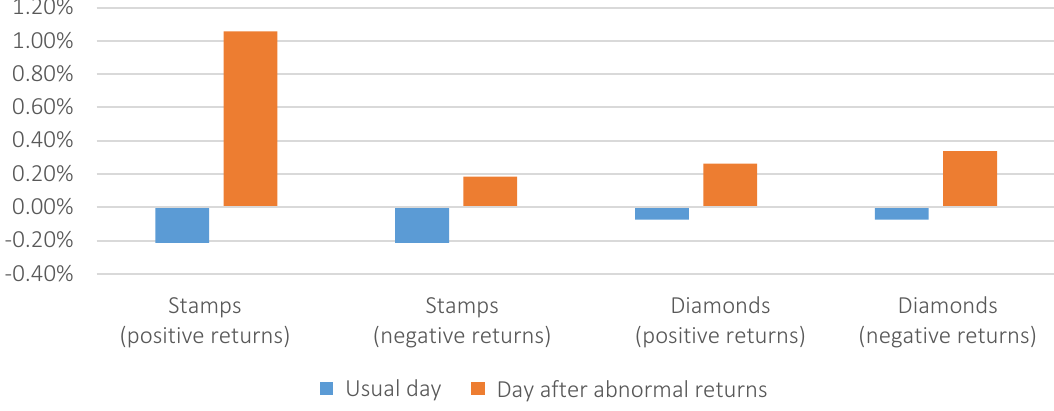
Figure 1. Visual (average) analysis of returns on ordinary days and days with abnormal returns (the case of stamps and diamonds)